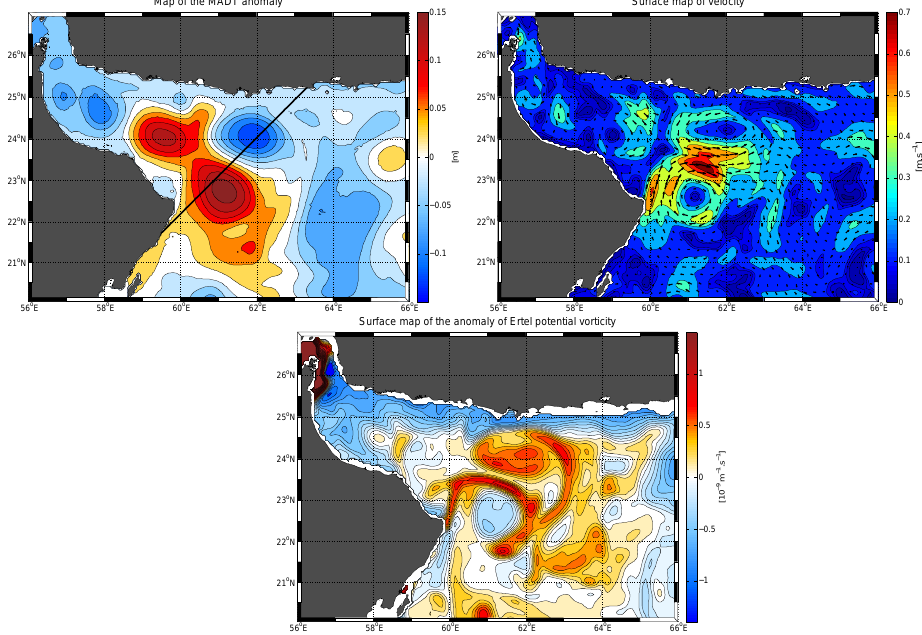
Figure 8. Maps from HYCOM showing the presence of mesoscale eddies: (upper left) MADT anomaly; (upper right) surface velocity; (lower panel) anomaly of Ertel potential vorticity. The anomalies of Ertel potential vorticity have an opposite sign inside and at the periphery of the eddies. This is primarily seen around the anticyclone north of Ra’s Al Hadd, the cyclone interacting with the coastal negative anomaly of Ertel potential vorticity.